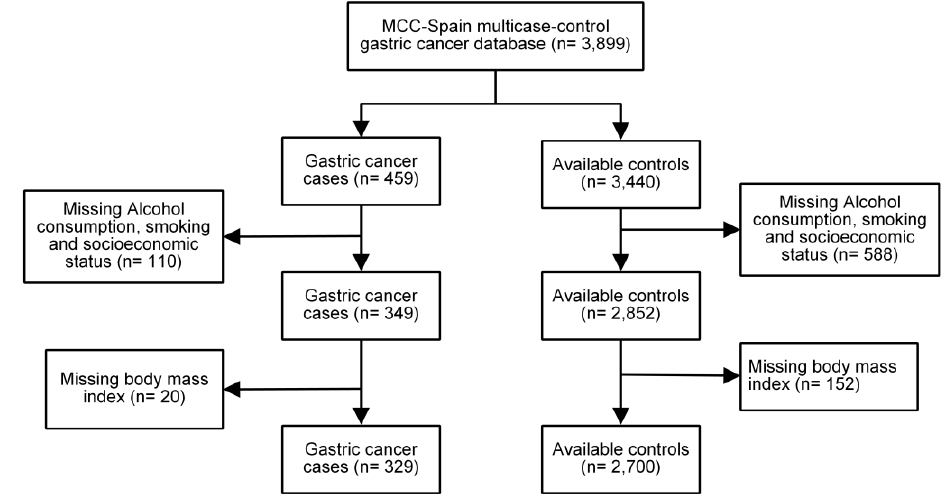
Figure 1. Algorithm for selection of controls and cases.